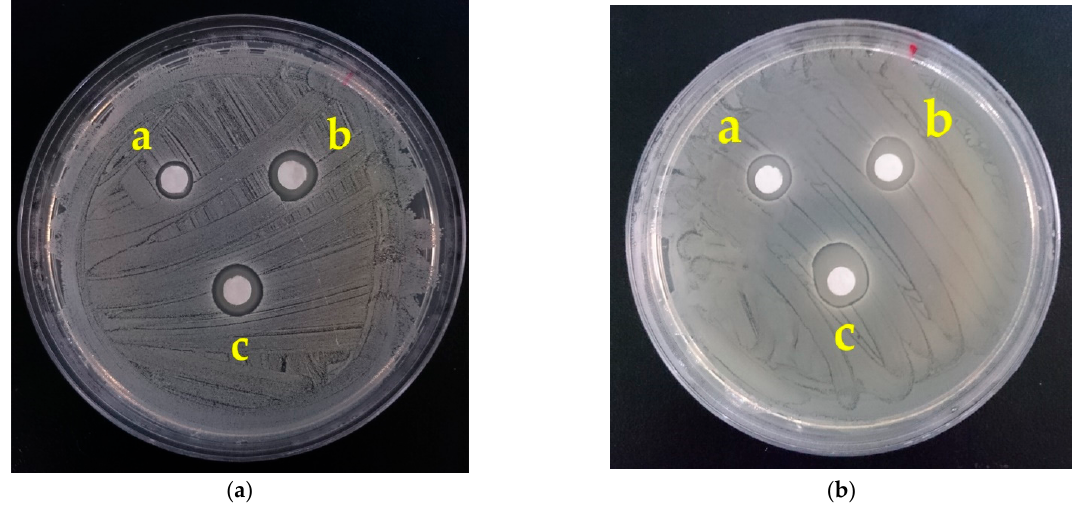
Figure 4. Bacteriostatic zone of PVA/WS-CS nanofibrous membranes with a blending ratio of ( a ) 80/20 and ( b ) 60/40, where the WS-CS concentrations were 5, 10, and 15 wt% for membranes a, b, and c, respectively.